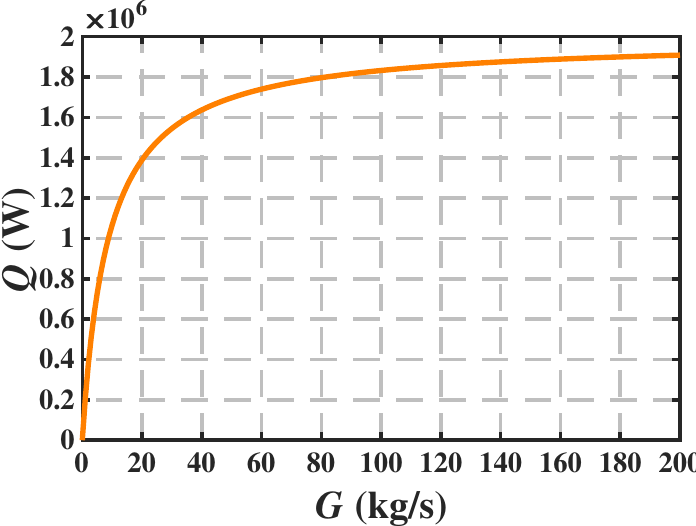
Figure 6. Capability limit of a